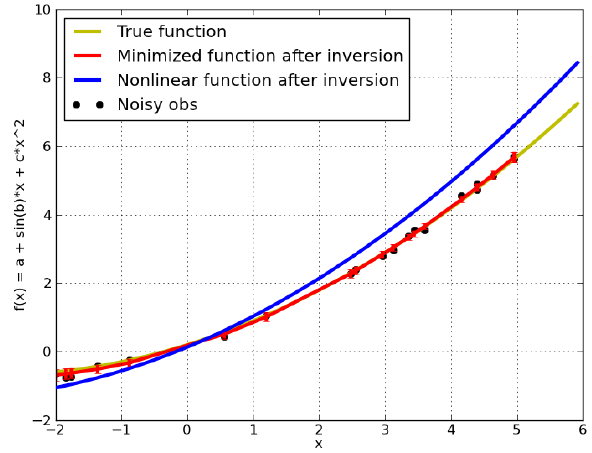
Fig. C1. An illustration of the effect of non-linearity on the results of the